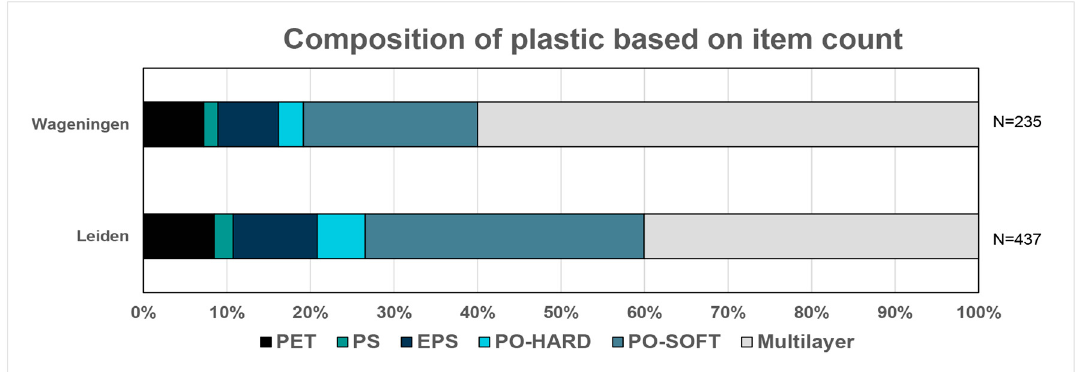
Figure 6. Plastic item categories for Leiden and Wageningen on 6 and 5 March 2020, respectively. Note that no observed items were classified as